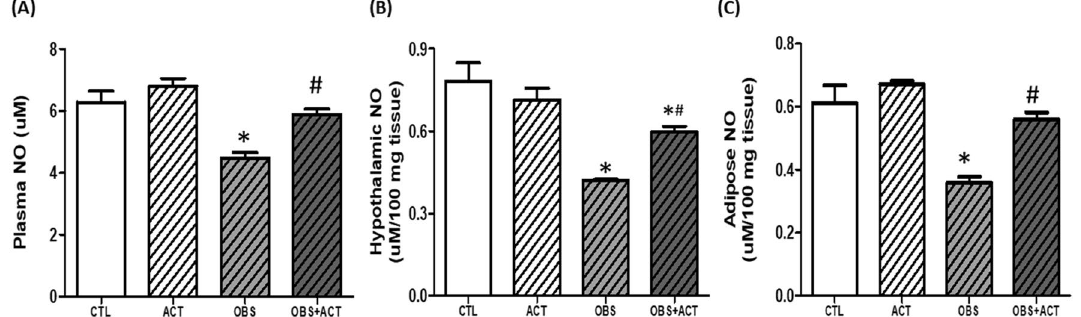
Figure 8. Effects of acetate on plasma, hypothalamic and adipose nitric oxide concentration ( A – C ) in high fat diet-induced obese Wistar rats. Plasma, hypothalamic and adipose NO increased in obese rats, which were reduced following the administration of acetate. Data are expressed as mean ± SD. n = 6 and analyzed by one-way ANOVA followed by Bonferroni post hoc test. (* p < 0.05 vs. CTL; # p < 0.05 vs. OBS). CTL Control, OBS Obesity, ACT Acetate, NO Nitric